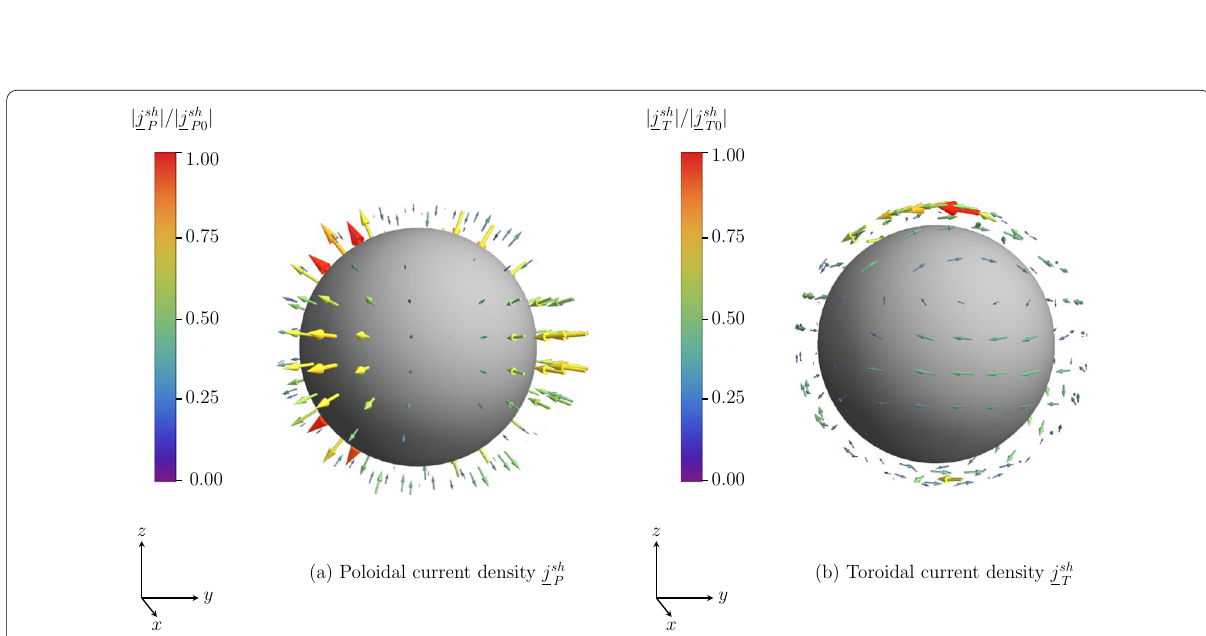
Fig. 3 Decomposition of the reconstructed current density j sh into its poloidal and toroidal parts along the ellipsoid E on the nightside of Mercury. The poloidal current density is presented in multiples of